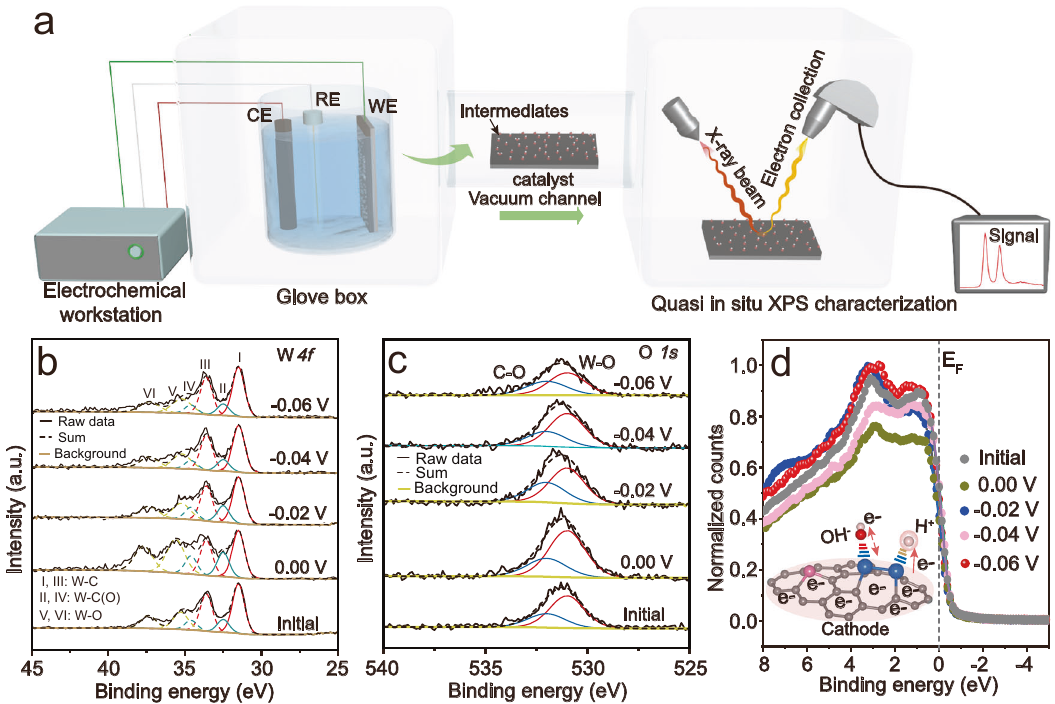
Fig. 4 Quasi in situ alkaline HER measurements for W-ACs treated at different applied potentials. a Schematic illustration of the quasi in situ alkaline HER experimental setup, where WE, RE, and CE represent the working, reference and counter electrodes, respectively. b W 4 f and ( c ) O 1 s core-level XPS spectra of W-ACs treated at 0.00, – 0.02, – 0.04, and – 0.06 V versus RHE and soaked in KOH solution, respectively. d The corresponding valence band of above treated W-AC samples. Inset shows the typical desorption of H* and OH* intermediates from W-W